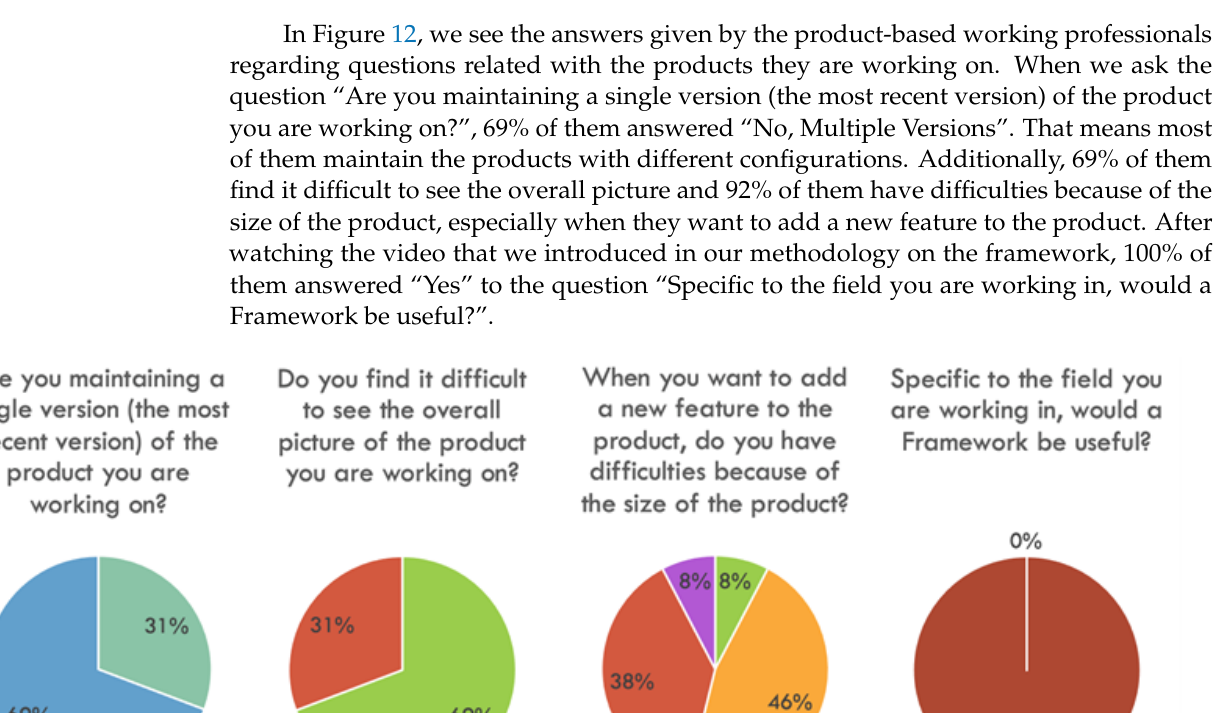
Figure 11. Profile of the professionals.